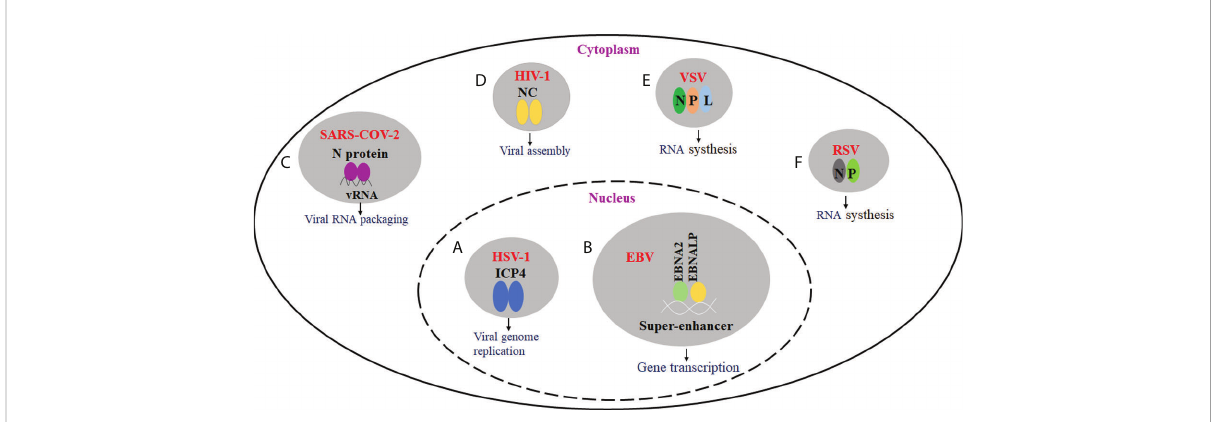
FIGURE 1 The effect of virus-driven phase separation on the viral infection. (A) HSV-1 ICP4 can drive the formation of condensates in the nucleus via LLPS. ICP4 is localized to RCs and required for viral replication. (B) EBV EBNA2, EBNALP, and other transcription factors could form condensate at super-enhancers via LLPS. They may be involved in the epigenetic regulation of chromatin activation. (C) SARS-CoV-2 N protein can undergo LLPS in the presence of viral RNA, and LLPS may be implicated in the assembly of progeny virions. (D) For HIV-1, nucleocapsid (NC)-mediated LLPS induces translational silencing and drives viral assembly. (E) IBs are proved to be membraneless organelles. For VSV, viral IBs were formed in the presence of N, P, and L proteins, and viral RNA synthesis occurs in IBs. (F) For RSV, viral IBs were formed in the presence of N and P proteins, which play an important role in viral RNA